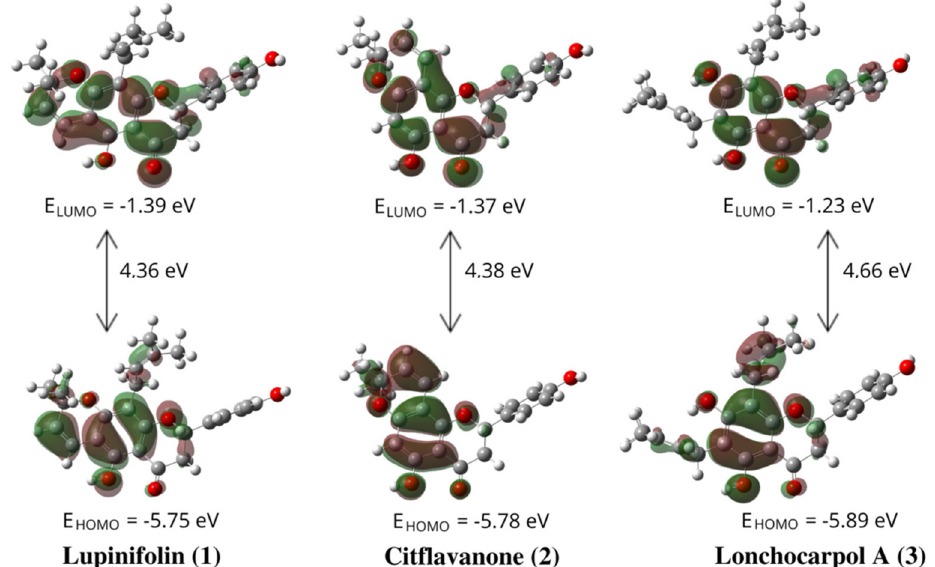
Figure 5. The energy and distribution of frontier orbital (HOMO and LUMO) of flavanones ( 1–3 ) in the gas phase.